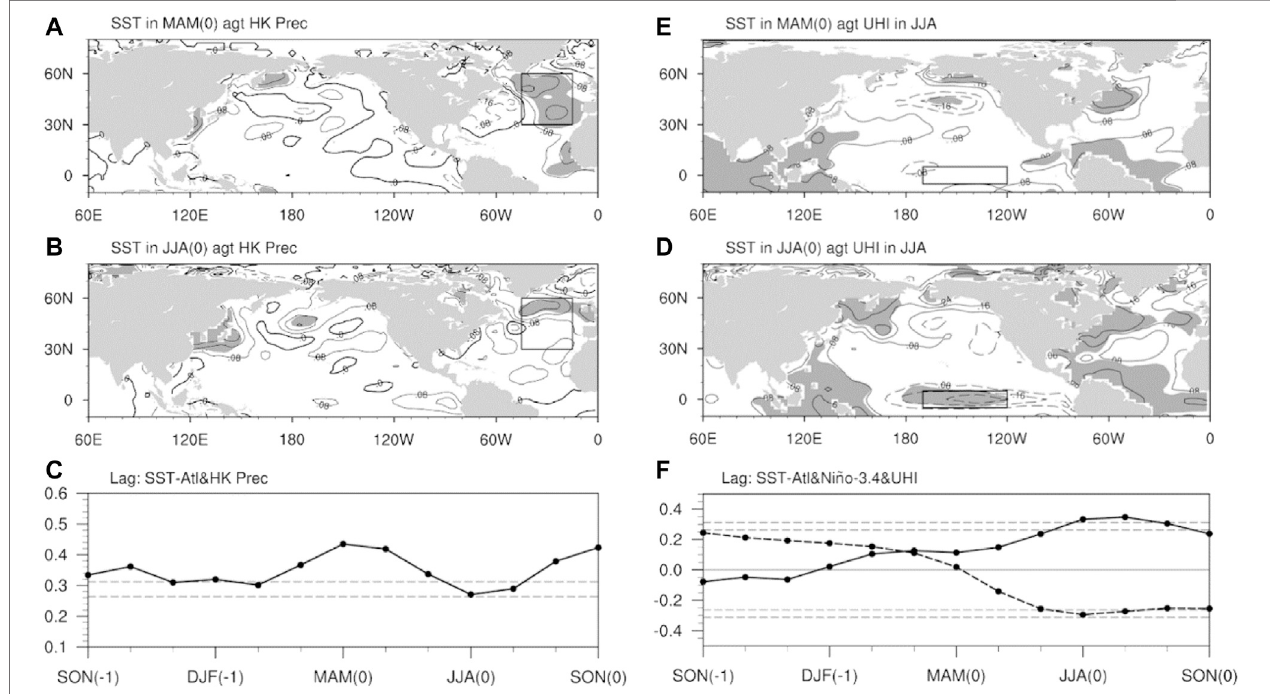
FIGURE 3 | Regression of (A,B) summer HK Prec and (D,E) summer UHI onto SST in (A,D) spring (March-April-May, MAM) and (B,E) summer. (C) Lead – lag correlation between HK Prec and seasonal mean SST in the North Atlantic enclosed by the black box (30 ° – 60 ° N, 45 ° – 15 ° W; SST-Atl) from the preceding autumn to the concurrentautumn. (F) Sameas (C) ,exceptforthelead – lagcorrelationbetweenUHIandSST-Atl(dottedsolidline)andtheNiño3.4index(dotteddashedline).TheNiño 3.4 region is denoted by the black box (5 ° S – 5 ° N, 120 ° – 170 ° W) in (D,E) . Dashed lines in (C,F) indicate the 90% and 95% con fi dence levels.